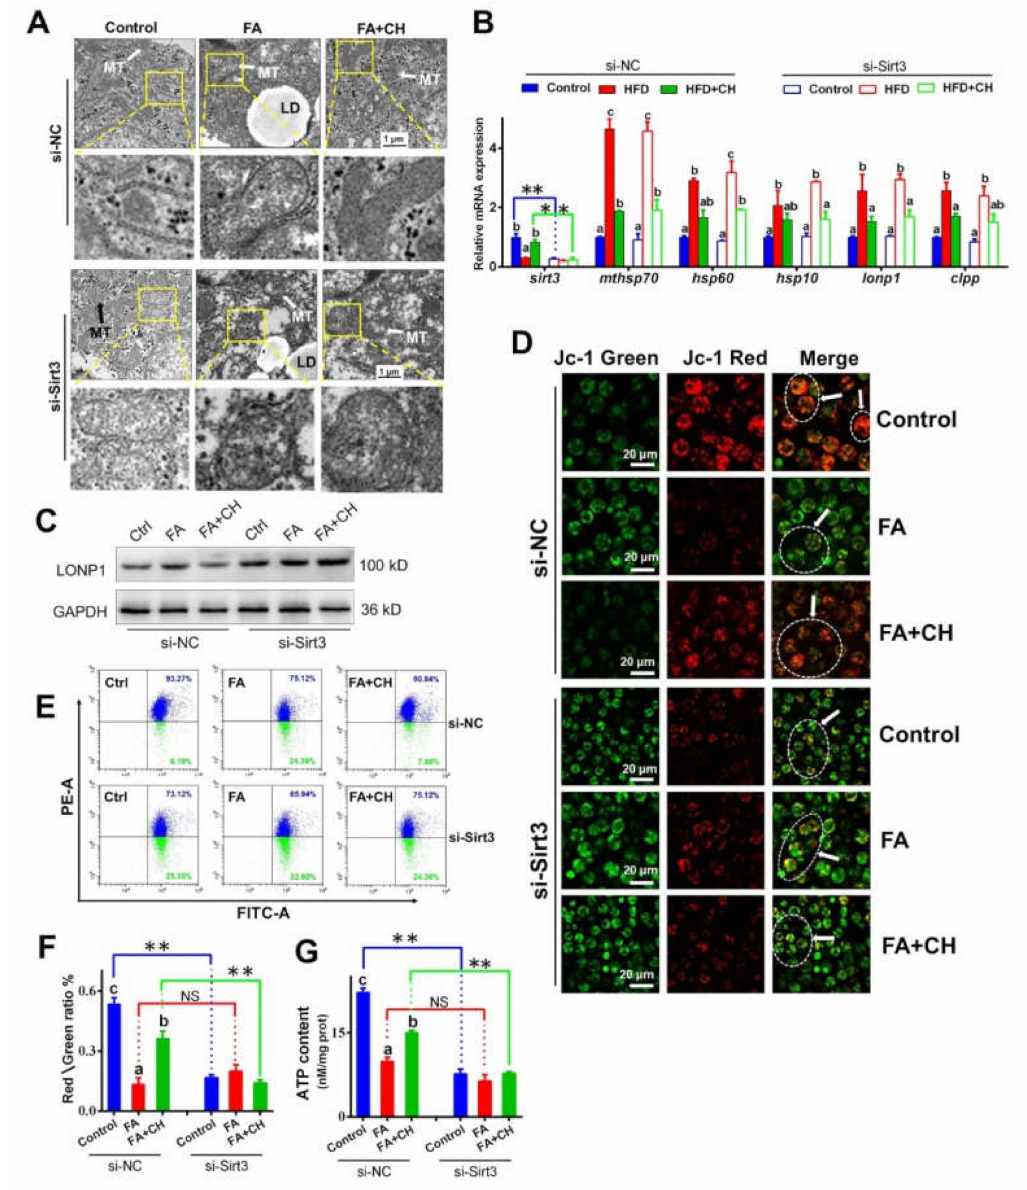
Figure 5. SIRT3/mtHSP70-mediated UPRmt is necessary for choline-ameliorating FA-induced mito- chondrial dysfunction in the hepatocytes of yellow catfish. ( A ) TEM structures of the hepatocytes incubated by FA and transfected with SIRT3 siRNA, MT, lipid droplet (LD); scale bars, 1 µ m. ( B ) The mRNA levels of the genes related to SIRT3 and UPRmt. ( C ) Western blot analysis of LONP1. ( D , E ) Images of hepatocytes stained by JC-1 output by fluorescence scanning confocal microscopy (D, bars = 20 µ m) and flow cytometry analysis ( E ) under FA incubation and transfected with SIRT3 siRNA. Representative images of confocal microscopy were marked with arrows. ( F ) Quantitative analysis for the relative ratio of red/green fluorescence intensity. ( G ) The ATP content. Values are mean ± SEM ( n = 3 independent biological experiments); different letters indicate significant differences among same si-NC or si-SIRT3 groups ( p ≤ 0.05); asterisks indicate significant differences between si-NC and si- SIRT3 groups (* p ≤ 0.05; ** p ≤